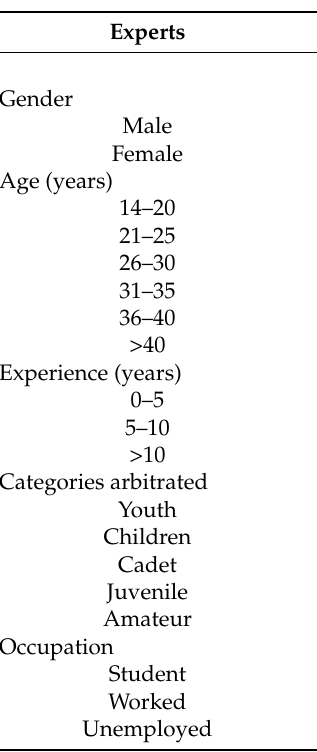
Table 1. Data from the sample of the grassroots football